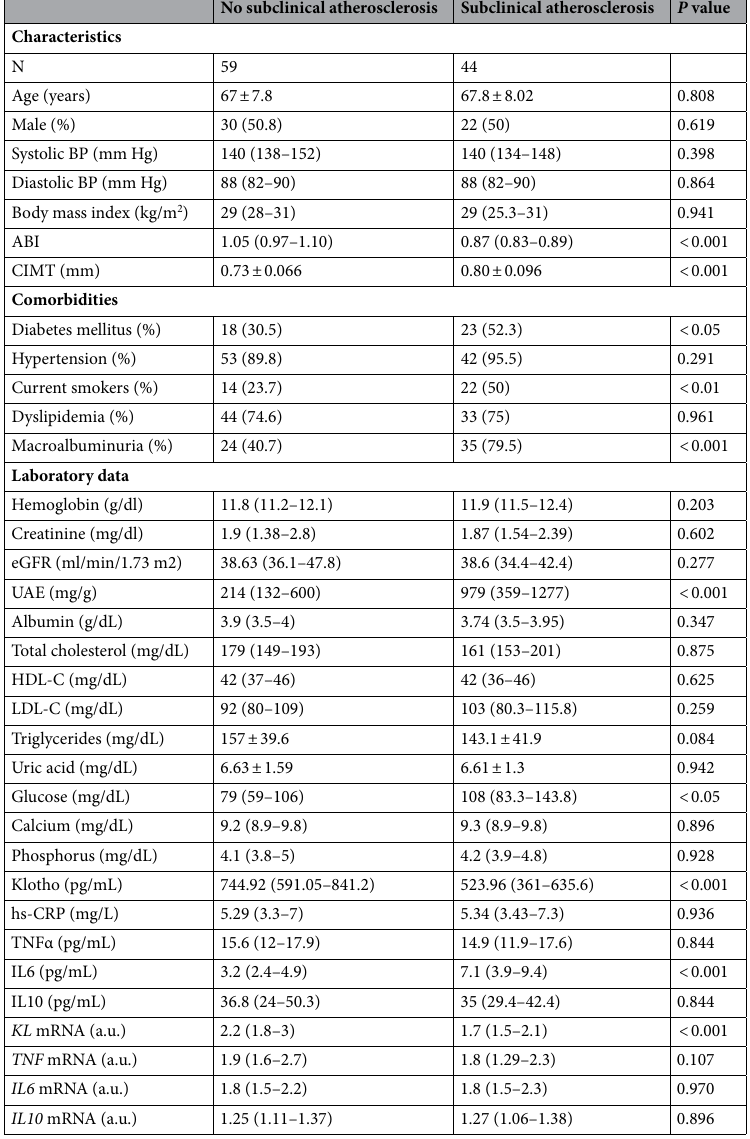
Table 1. Clinical characteristics. Biochemical assessments and gene expression analysis according to the presence of subclinical cardiovascular disease. BP blood pressure, ABI ankle-brachial index, CIMT carotid protein, TNFα tumor necrosis factor, IL interleukin KL Klotho